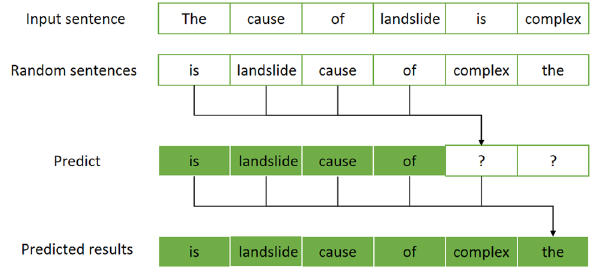
Figure 2. PLM mechanism demo